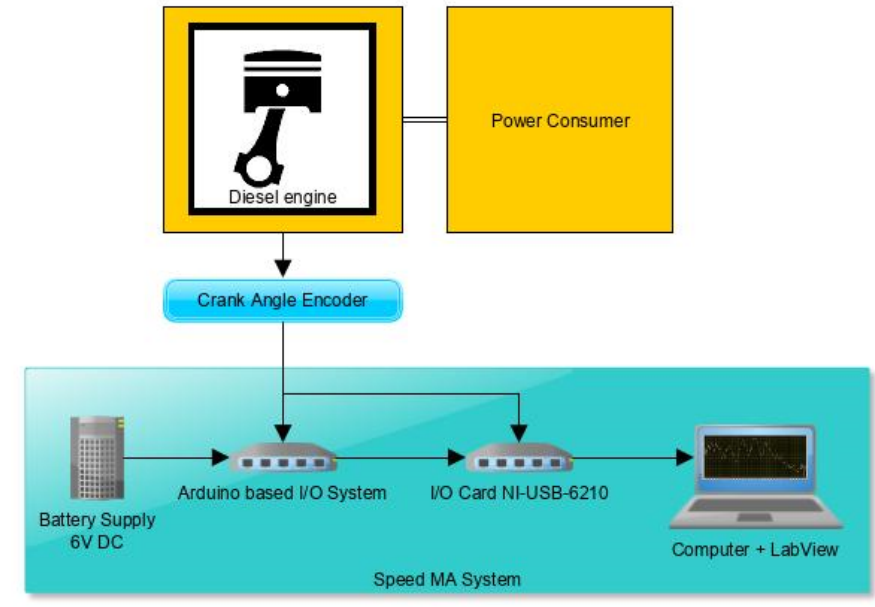
Figure 4. Diagram of the SpeedMA measuring system.